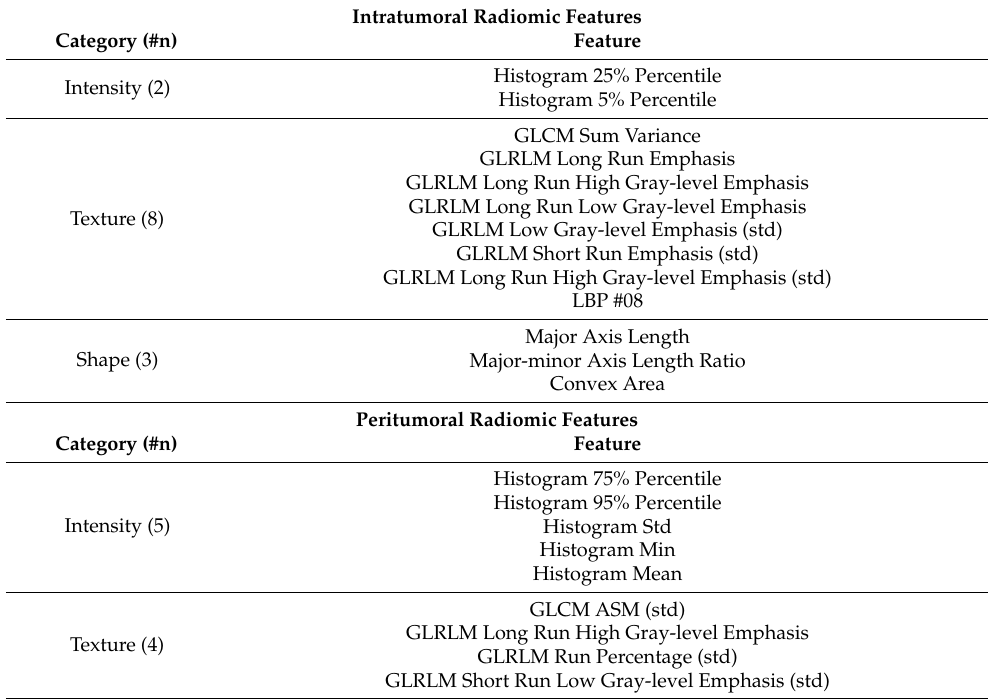
Table 6. List of significant radiomic features of intratumoral and peritumoral